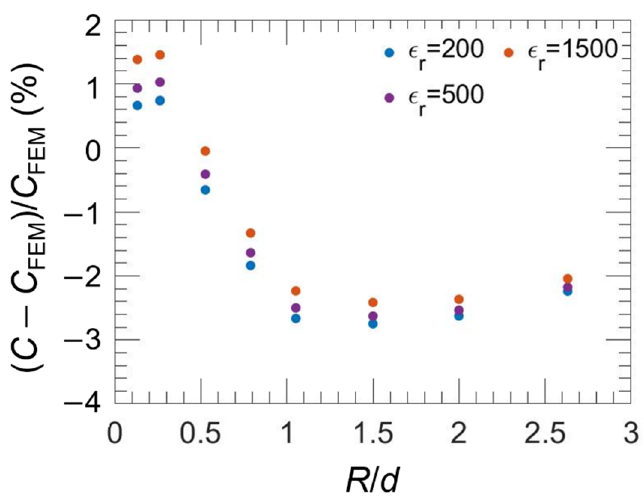
Figure 3. Relative differences ( C — C FEM )/ C FEM in% as a function of R / d , with R ranging from 0.10 µm to 1.2 µm and d fixed at 1 µm, for four values of ε r (200, 500, 1500).